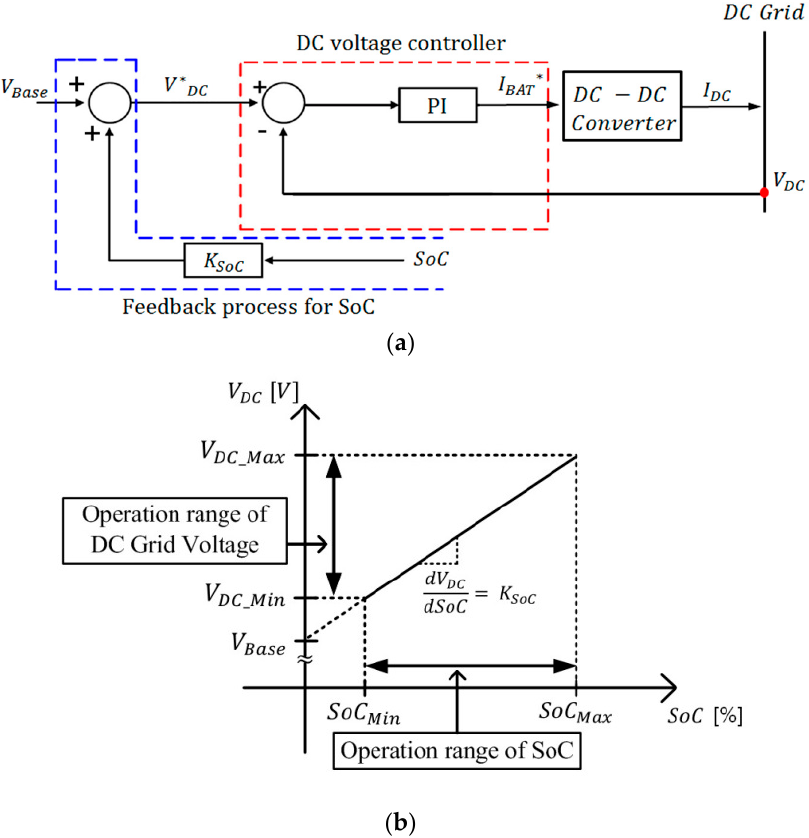
K K relationship. relationship. Figure 4. Proposed control method: ( a ) reference grid voltage; and ( b ) K SoC